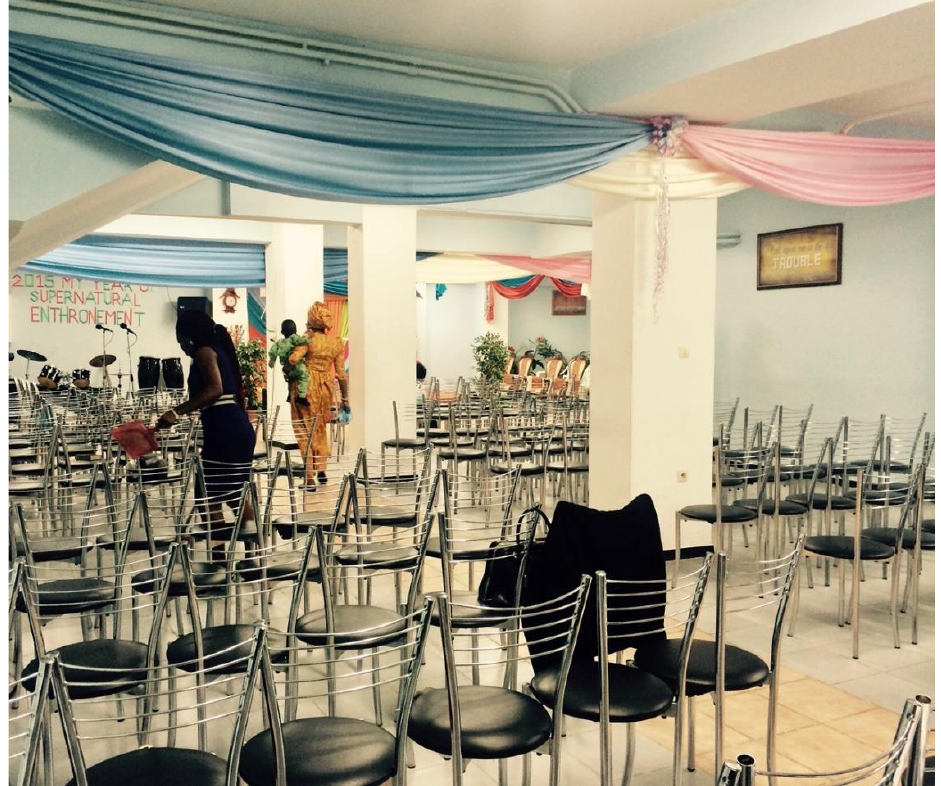
Figure 6: African Church, Athens (photo: Viki